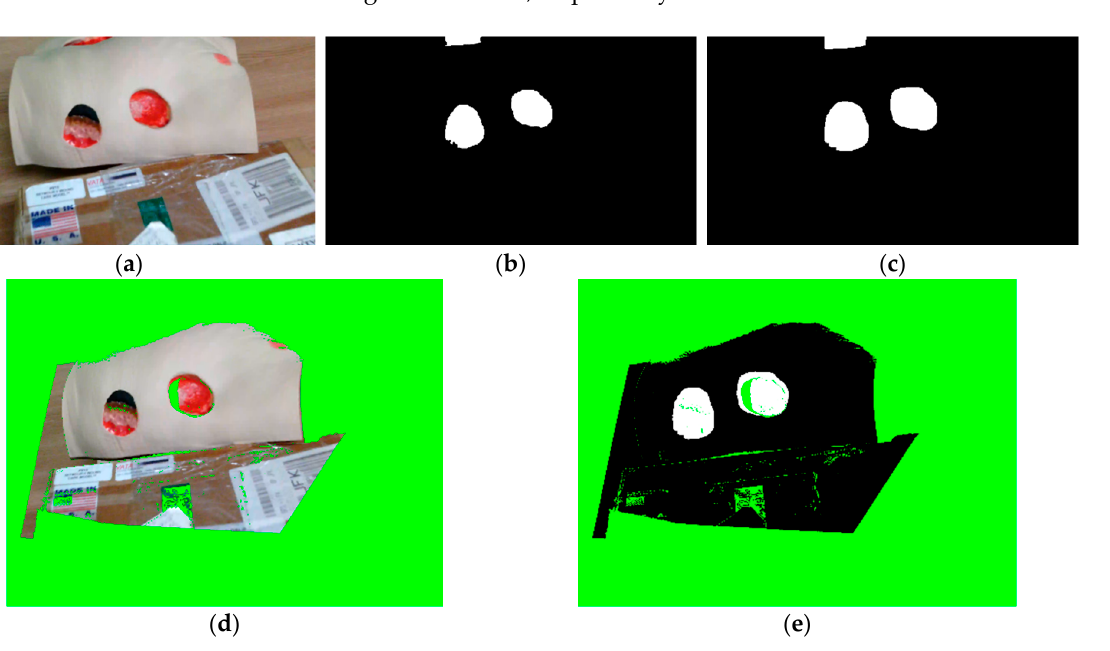
Figure 7. Example of registering binary masks to PhoXi depth images: ( a ) input RGB image made by Kinova vision module; ( b ) binary mask made during the 2D segmentation stage; ( c ) dilated binary mask; ( d ) registered RGB image—green color denotes pixels with no RGB value; ( e ) registered binary mask.